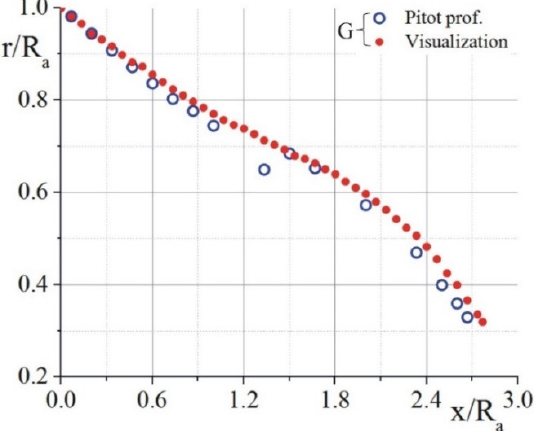
Figure 7. Spatial position of the gradient non-uniformity, or the line G in Figure 6, as determined from flow visualization and Pitot data.